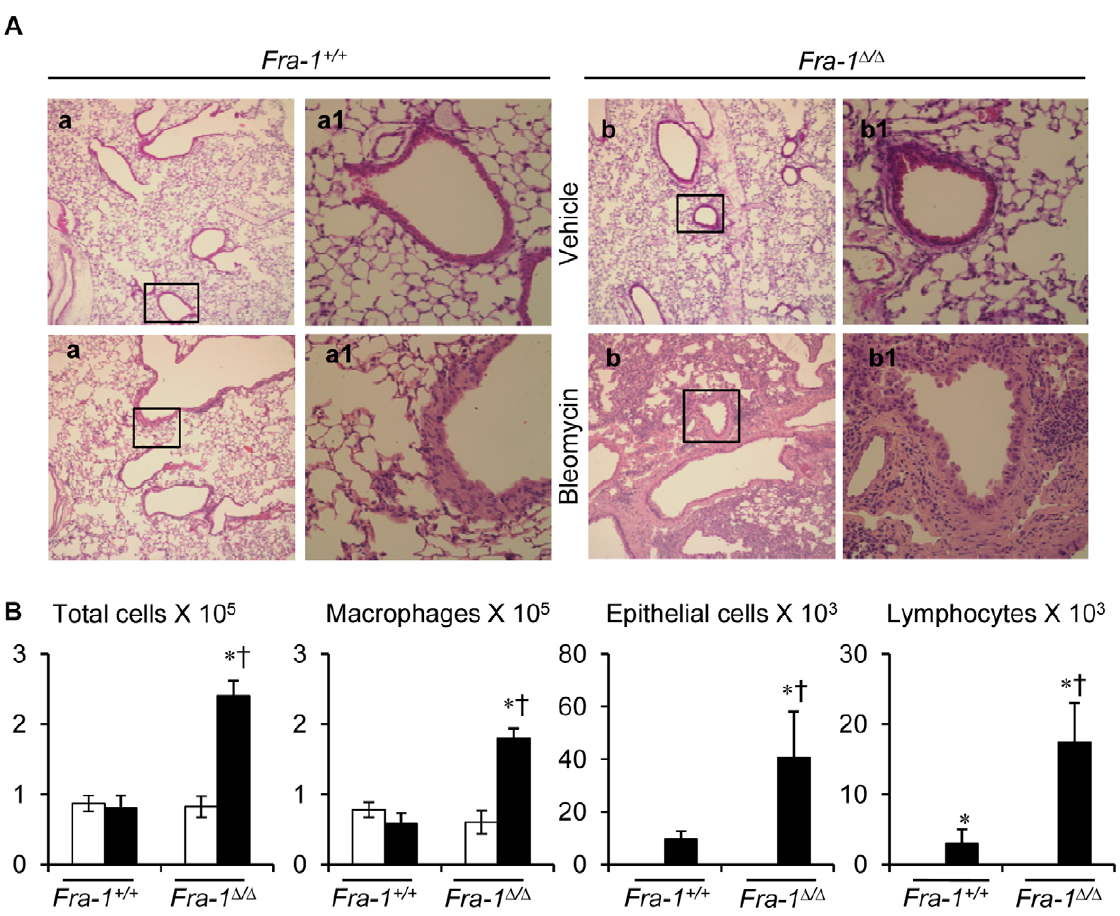
Figure 3. Fra-1 D / D mice demonstrate extensive pulmonary inflammation and fibrosis at 31-day post-bleomycin administration. Mice were intratracheally administered with bleomycin (n=14 2 15) or PBS (n=12) were assessed. Representative results of three different experiments are shown. A: Representative images of H&E stained lung tissue sections of bleomycin-treated Fra-1 + / + and Fra-1 D / D mice (n=4). B: Lung inflammatory cell profiles in BAL fluids at 31-day post-PBS and -bleomycin instillation (n=5). Open bars = vehicle; filled bars = bleomycin. p , 0.05, PBS vs bleomycin; { p , 0.05, Fra-1 D / D vs Fra-1 + / + mice. Images in a and b are shown at x10, whereas a1 and b1 represent boxed areas of a and b , respectively, shown at